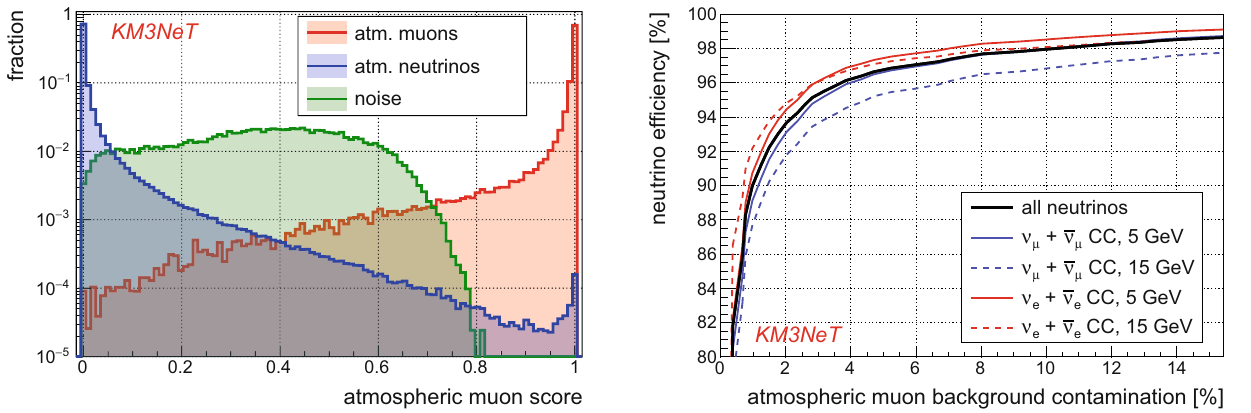
Fig. 4 Left: Distribution of the atmospheric muon score variable for the RDF trained to separate between neutrinos and atmospheric muons, for the main classes of events. Right: Fraction of remaining neutrinos weighted with an oscillated atmospheric flux versus atmospheric muon contamination in the final sample